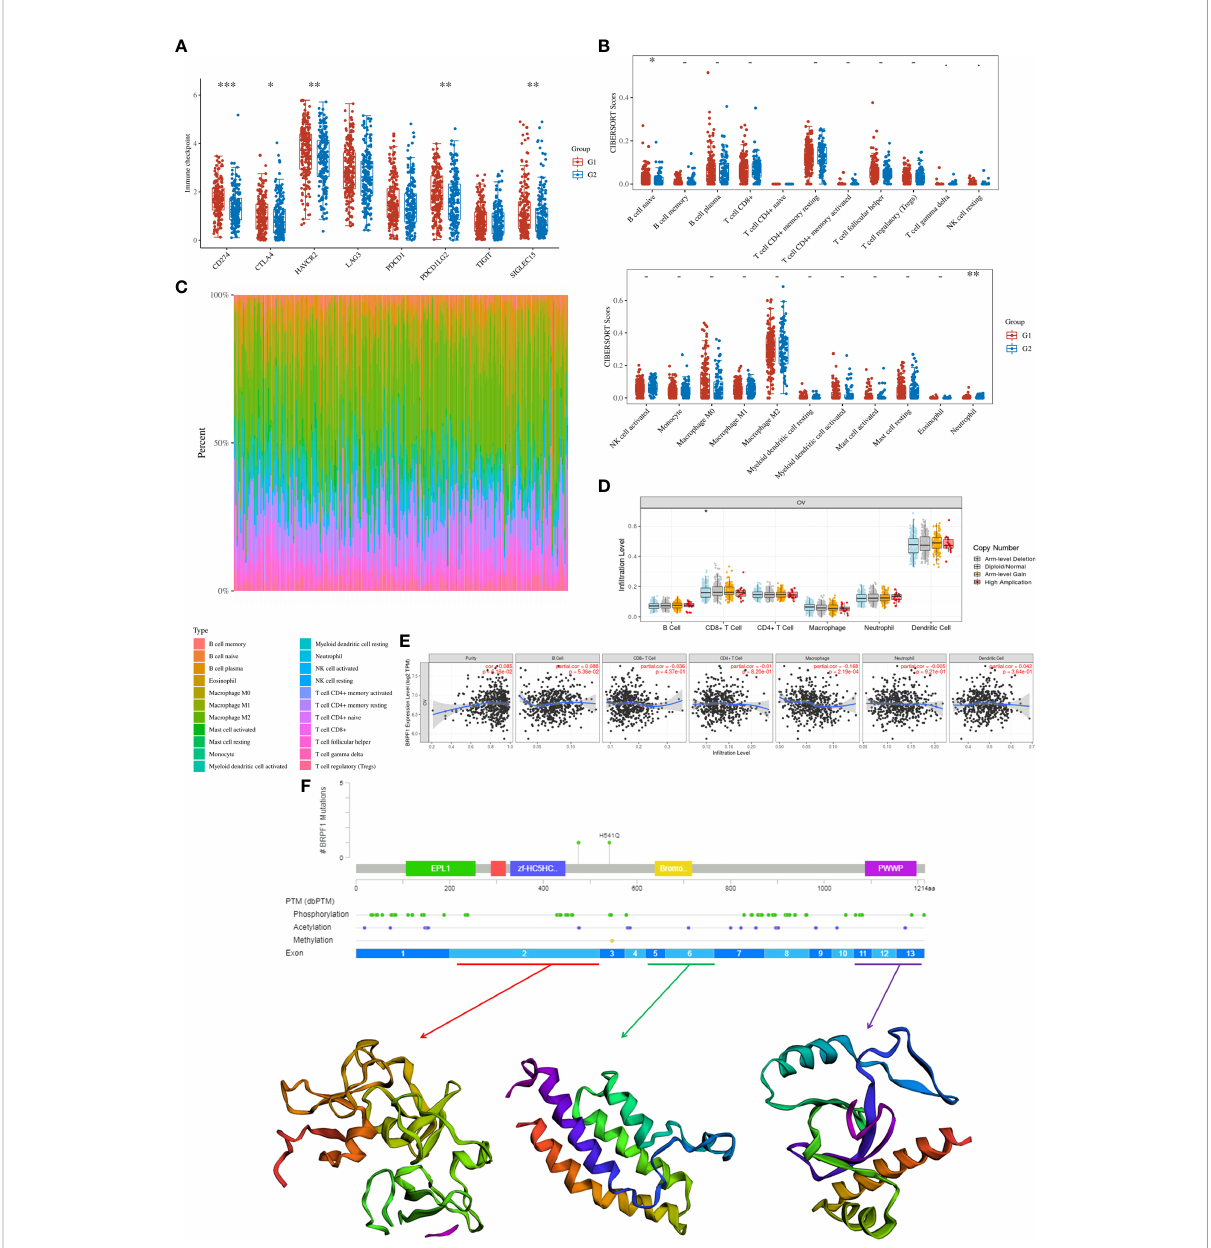
FIGURE 13 The role of BRPF1 in OC immune in fi ltration. (A) Immune cell expression distribution for the OC patients with high expression of BRPF1 compared to the OC patients with low expression of BRPF1. (B) The percentage abundances of different immune cell types in each sample. (C) Heatmap of immune checkpoint-related gene expression for the OC patients with high expression of BRPF1 compared to the OC patients with low expression of BRPF1. (D) The CNV analysis between BRPF1 alteration and immune in fi ltration based on TIMER database. (E) The expression level of BRPF1 and immune in fi ltration based on TIMER database. (F) The protein secondary structure of BRPF1 and the tertiary structure of BRPF1 protein for exon 1, exons 5-6, and exons 11-13. (G1 is the group of the OC patients with high expression of BRPF1. G2 is the group of the OC patients with low expression of BRPF1.) *p < 0.05; **p < 0.01; ***p <